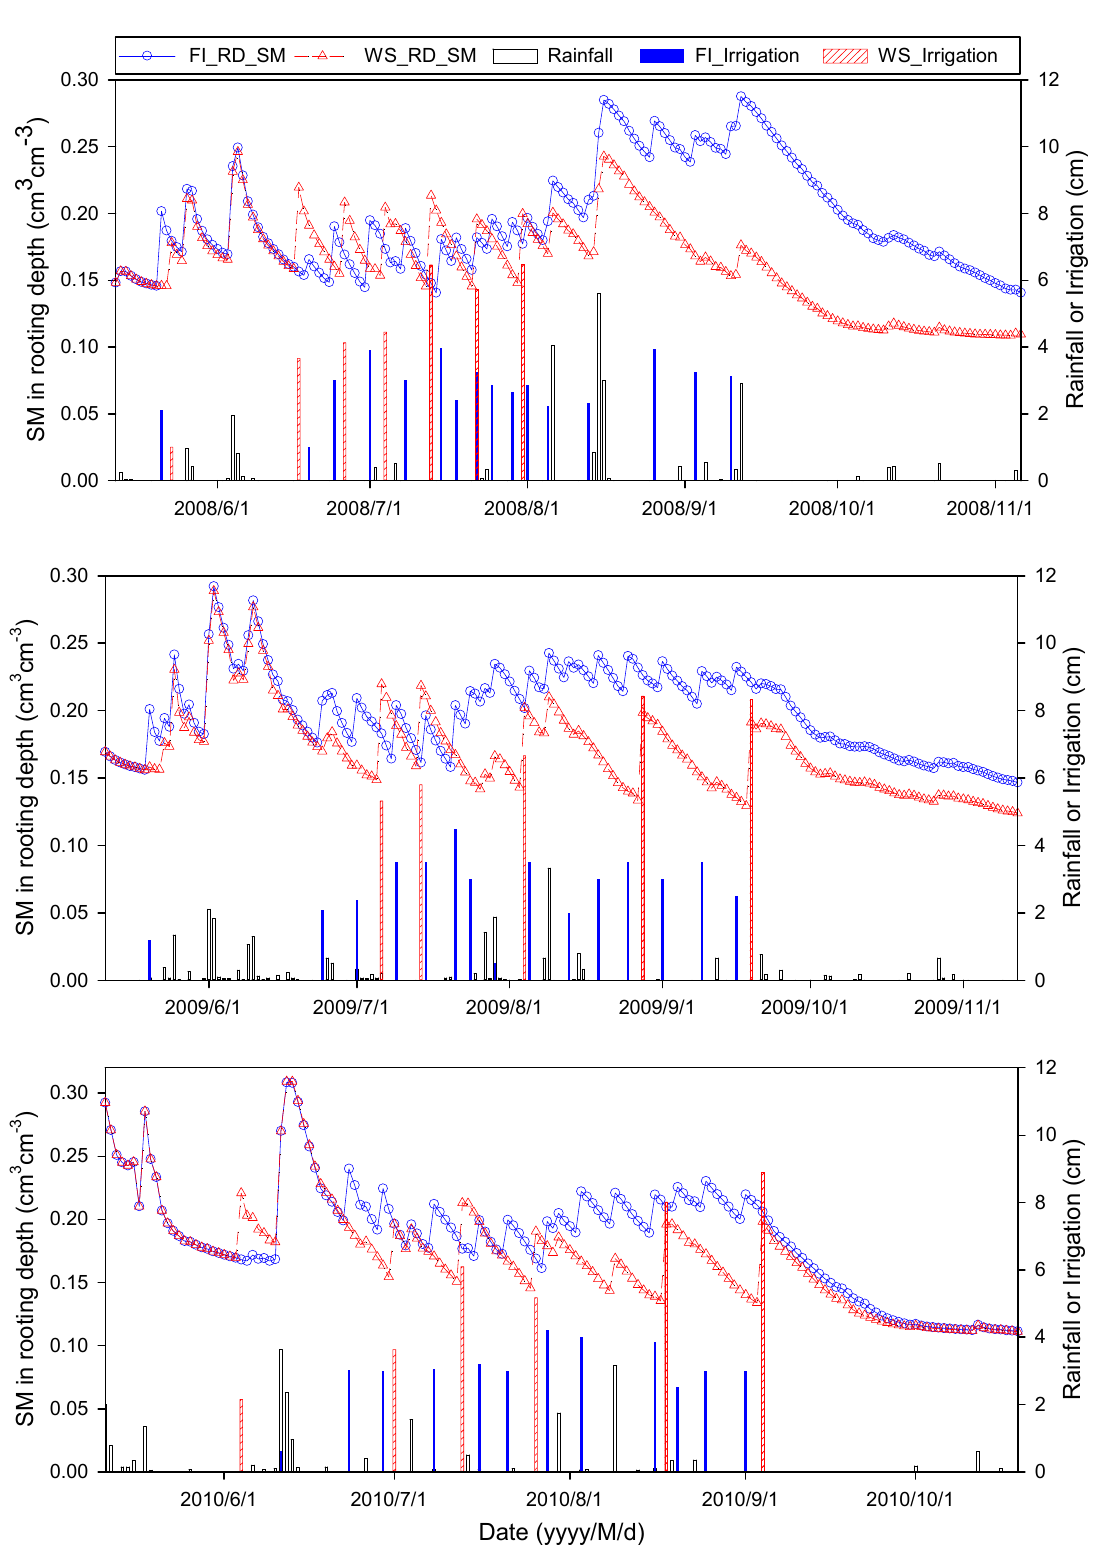
Figure 1. Simulated soil moisture (SM) dynamic in rooting depth under field irrigation (FI) and water stress (WS) irrigation regimes by RZWQM2 for three crop growing seasons. FI_RD_SM and WS_RD_SM are root zone soil moisture under FI and WS regimes, respectively.